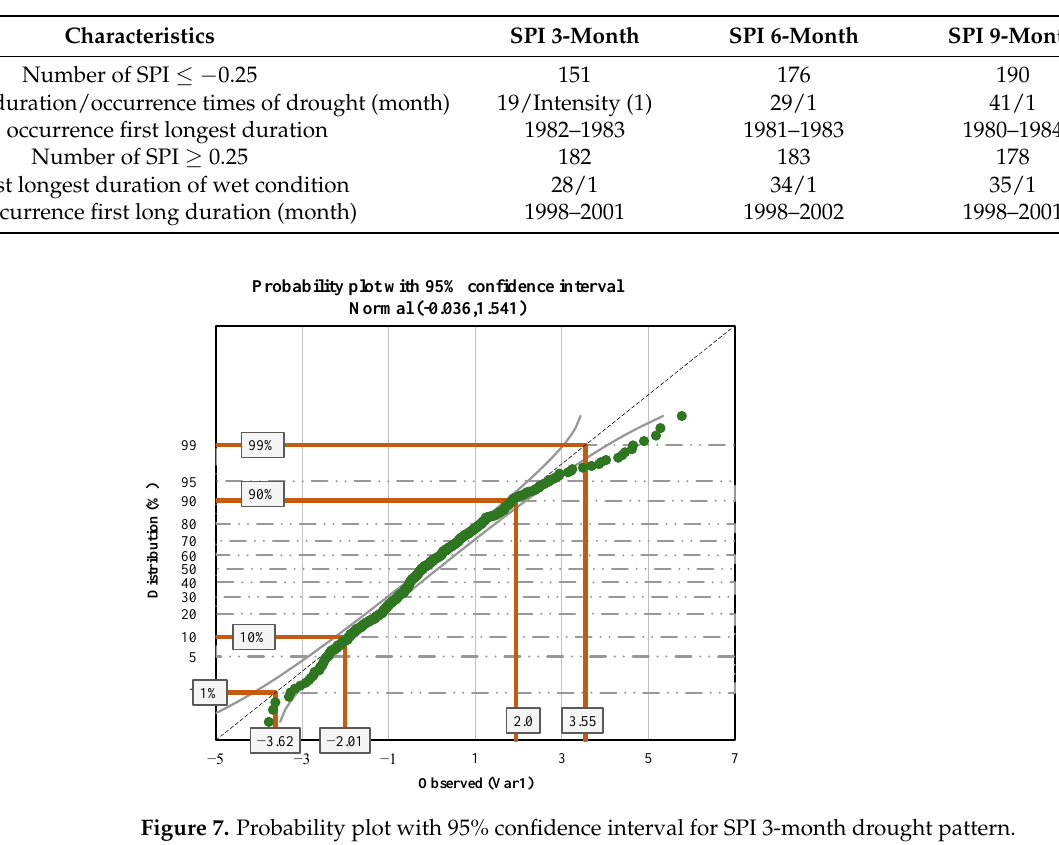
Table 2. Number of drought and wet events using SPI duration in 1980–2019.